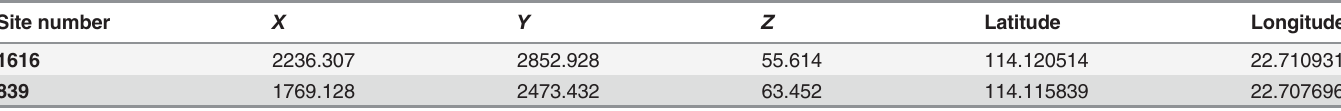
Table 4. The coordinates of complementary